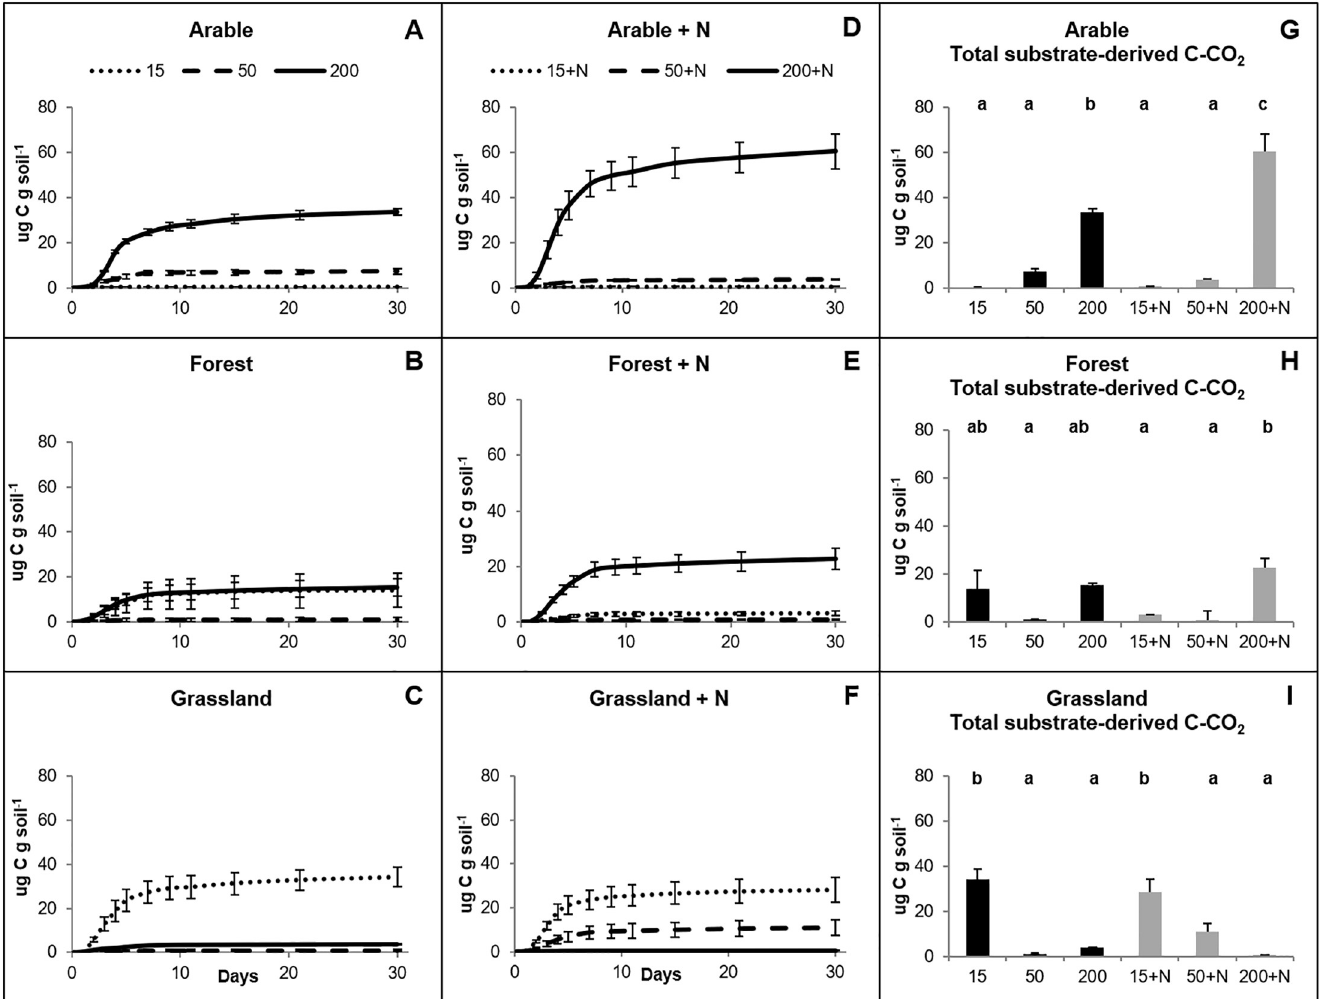
Fig 1. Substrate-derived CO 2 ( μ g C-CO 2 g dw soil -1 ) in soils from three ecosystems as induced by three different amounts of 13 C-glucose (15%, 50%, and 200% of the microbial biomass carbon). A-F: Cumulative accumulation of substrate-derived CO 2 over 30 days of incubation. G-H: Total substrate-derived CO 2 after 30 days of incubation. N: NH 4 NO 3 . Statistically significant differences (P < 0.05) are marked with different letters. NS: no significant differences. Error bars represent standard errors (n = 4). Two-way ANOVA results are reported in S1